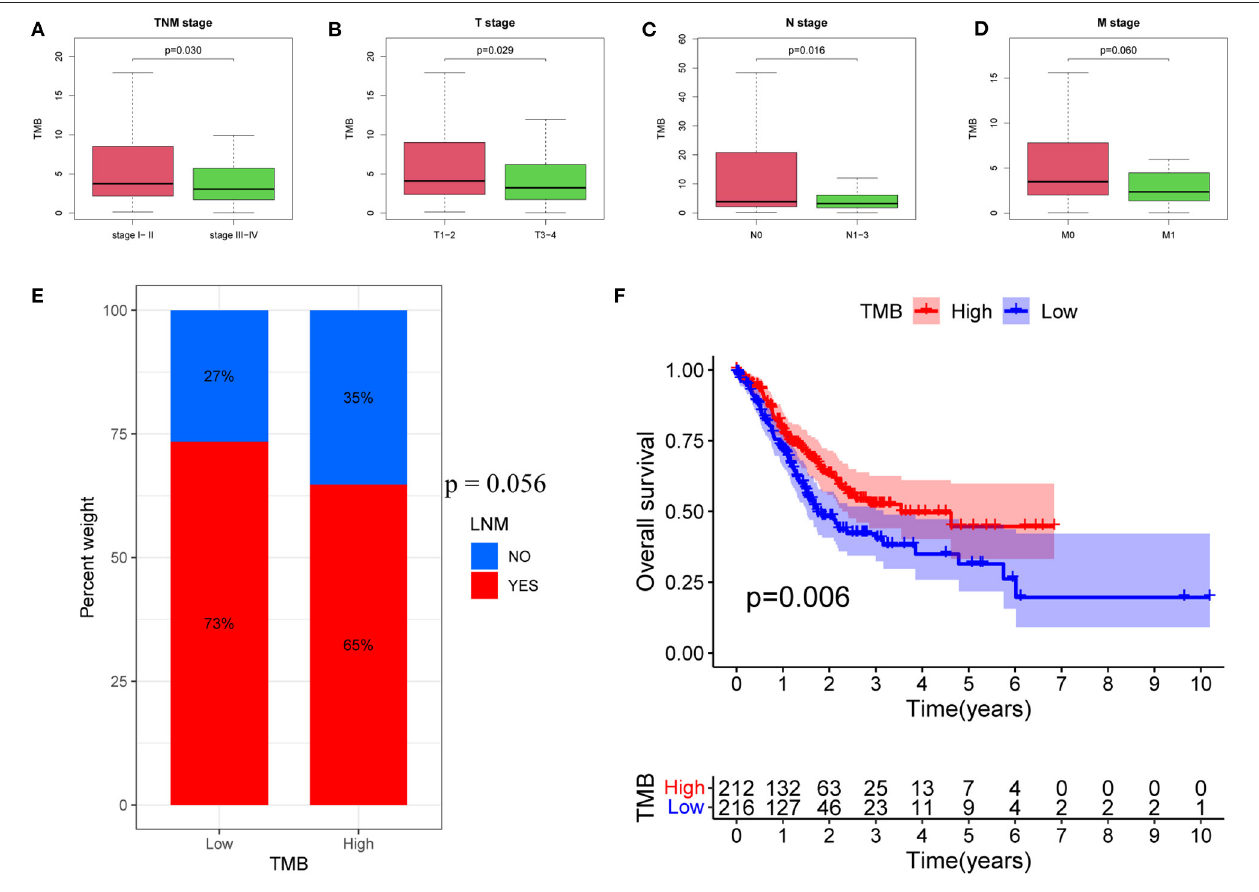
FIGURE 1 | Associations between TMB and clinical characteristics. (A) Association between TMB and TNM stage. (B) Association between TMB and T stage. (C) Association between TMB and N stage. (D) Association between TMB and M stage. (E) Proportions of patients with LNMs in high- and low-TMB groups. (F) Kaplan–Meier curves of OS for high- and low-TMB groups. TMB, tumor mutational burden; LNM, lymph node metastasis; OS, Overall Survival.